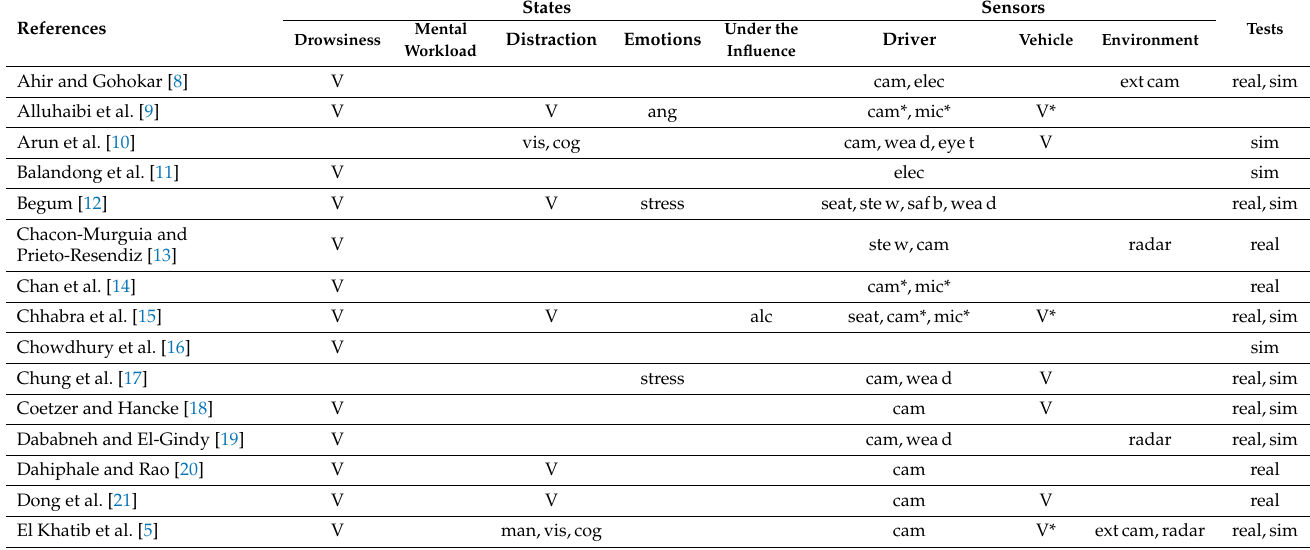
Table A1. This table gives the three main columns of Table 2 labelled “States”, “Sensors”, and “Tests”. The remaining main column “Indicators” is provided in Table A2. This partitioning of Table 2 allows for more comfortable visualization of its content when